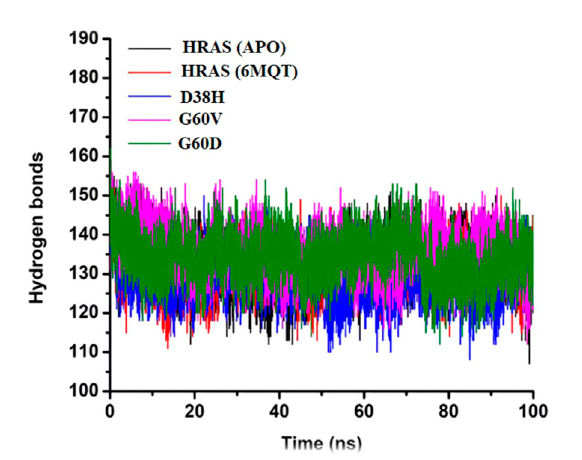
FIGURE 11 Presentingthenumberofhydrogenbondsofallthreecomplexes with the time interval of 100